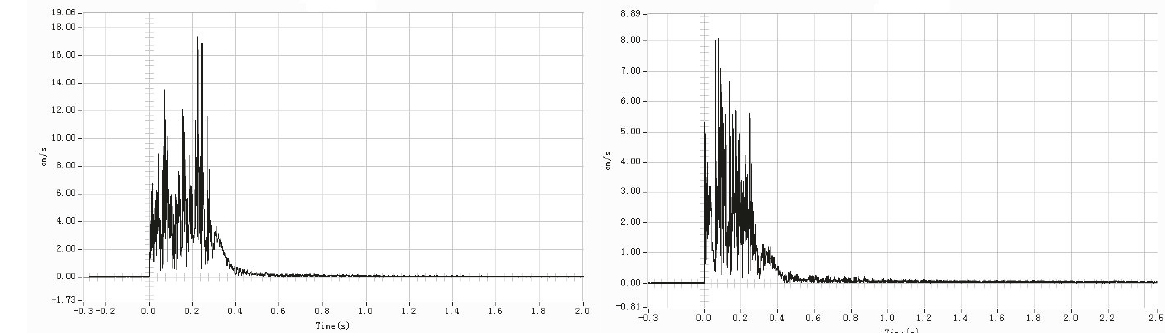
Figure 17: Typical waveforms of blasting vibration vector synthesis